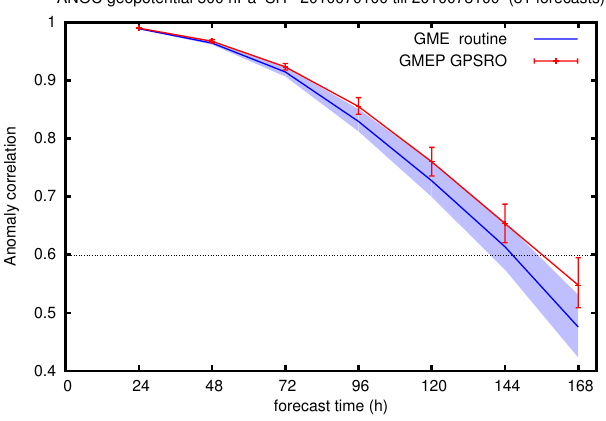
Fig. 5. Anomaly correlation of the 500hPa geopotential height in the Southern Hemisphere (90 ◦ S–20 ◦ S) of the reference (GME rou- tine, blue line) and of the GPSRO experiment (red line), based on the statistics from 31 forecasts during July 2010. The shaded blue area and the red error bars indicate the respective 90% confidence intervals derived from the bootstrap